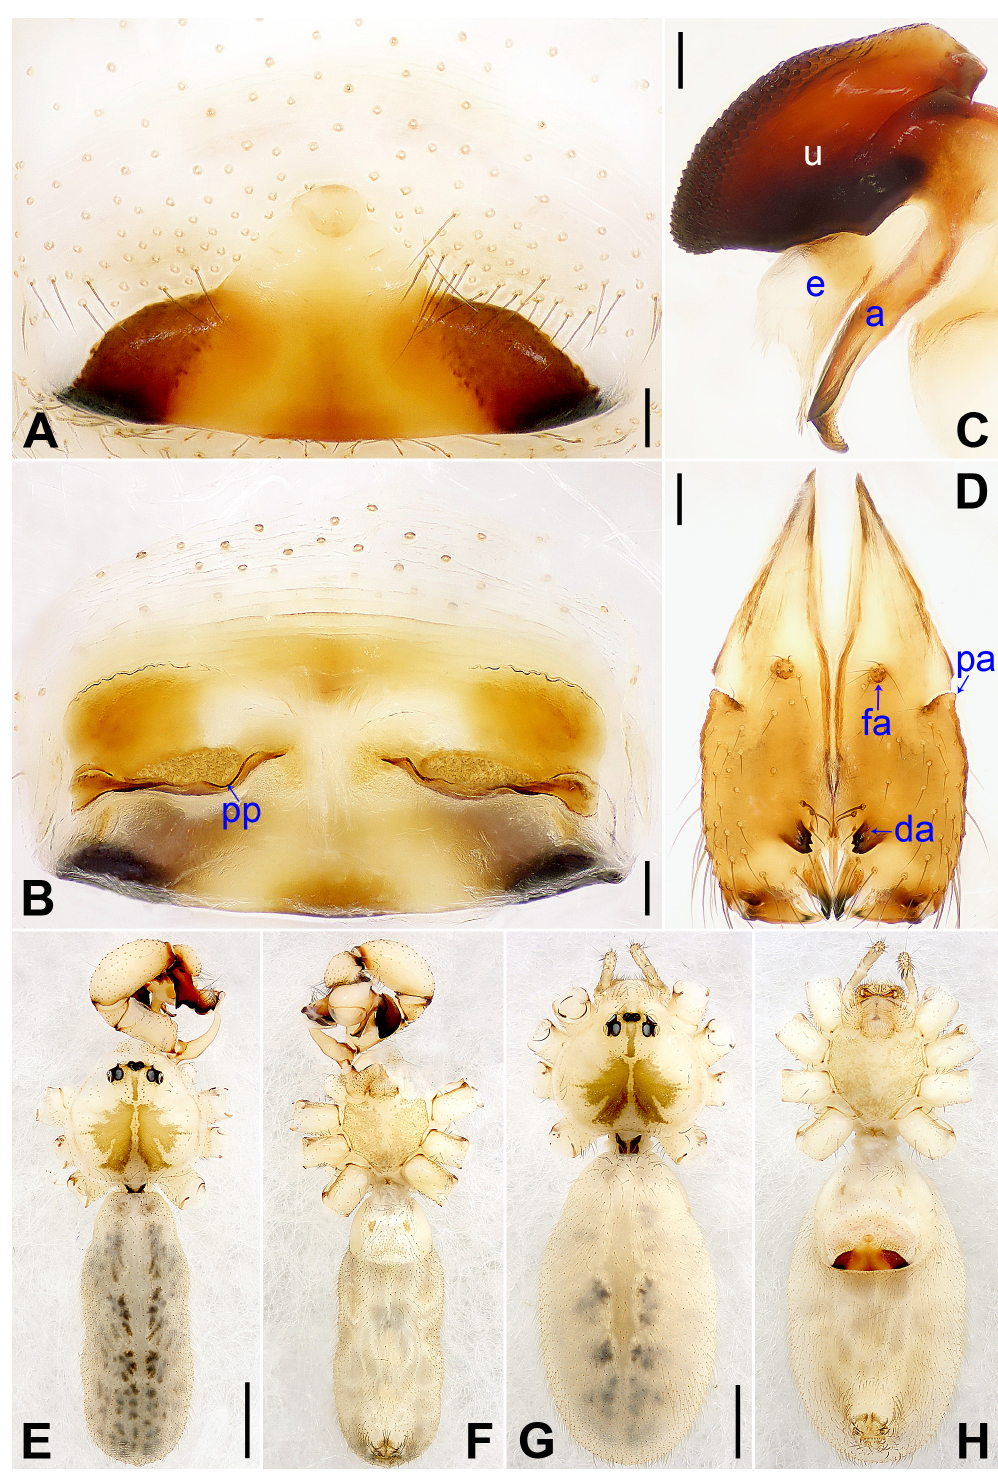
Fig. 6. Pholcus sidorenkoi Dunin, 1994, ♂ (C–F) and ♀ (A–B, G–H). A . External genitalia, ventral view. B . Vulva, dorsal view. C . Bulbal apophyses, prolateral view. D . Chelicerae, frontal view. E–H . abitus (E, G. Dorsal view. F, H. Ventral view). Abbreviations: a = appendix; da = distal apophysis; e = embolus; fa = frontal apophysis; pa = proximo-lateral apophysis; pp = pore plate; u = uncus. Scale bars: A–D = 0.10 mm; E–H = 1.00